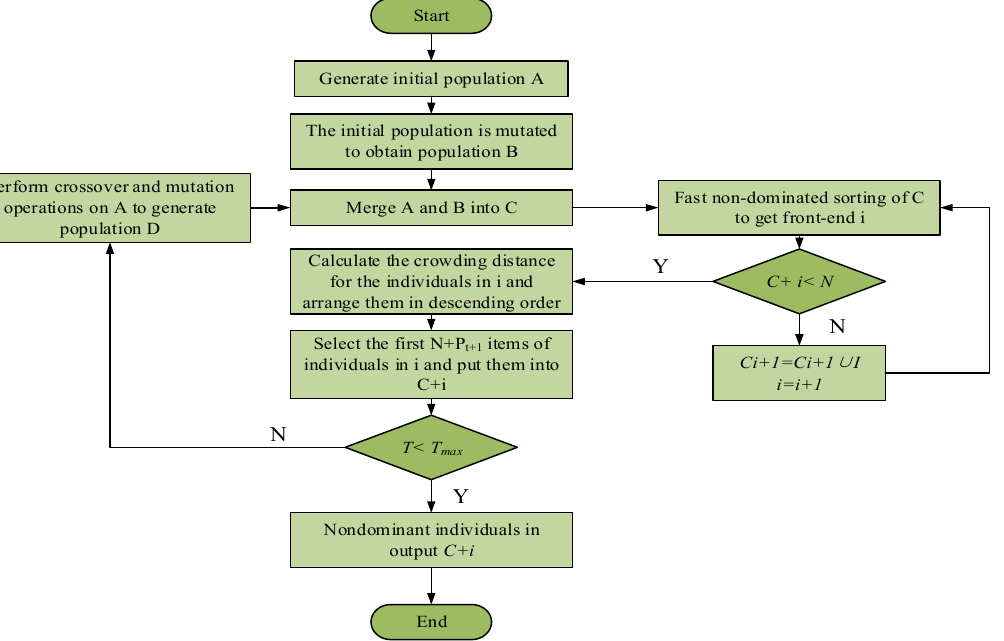
Figure 2. Specific process of NSGA-II algorithm.